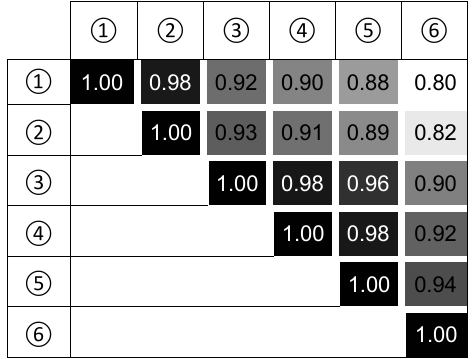
Figure A2. Carbon balance of the triple-phase process. Analyzed products (biomass, lactate, succinate, acetate and CO 2 ) were balanced with respect to glucose as sole carbon source over the entire cultivation period of 0–16 h (Figure 1A). Error bars represent the SD of four independent experiments.